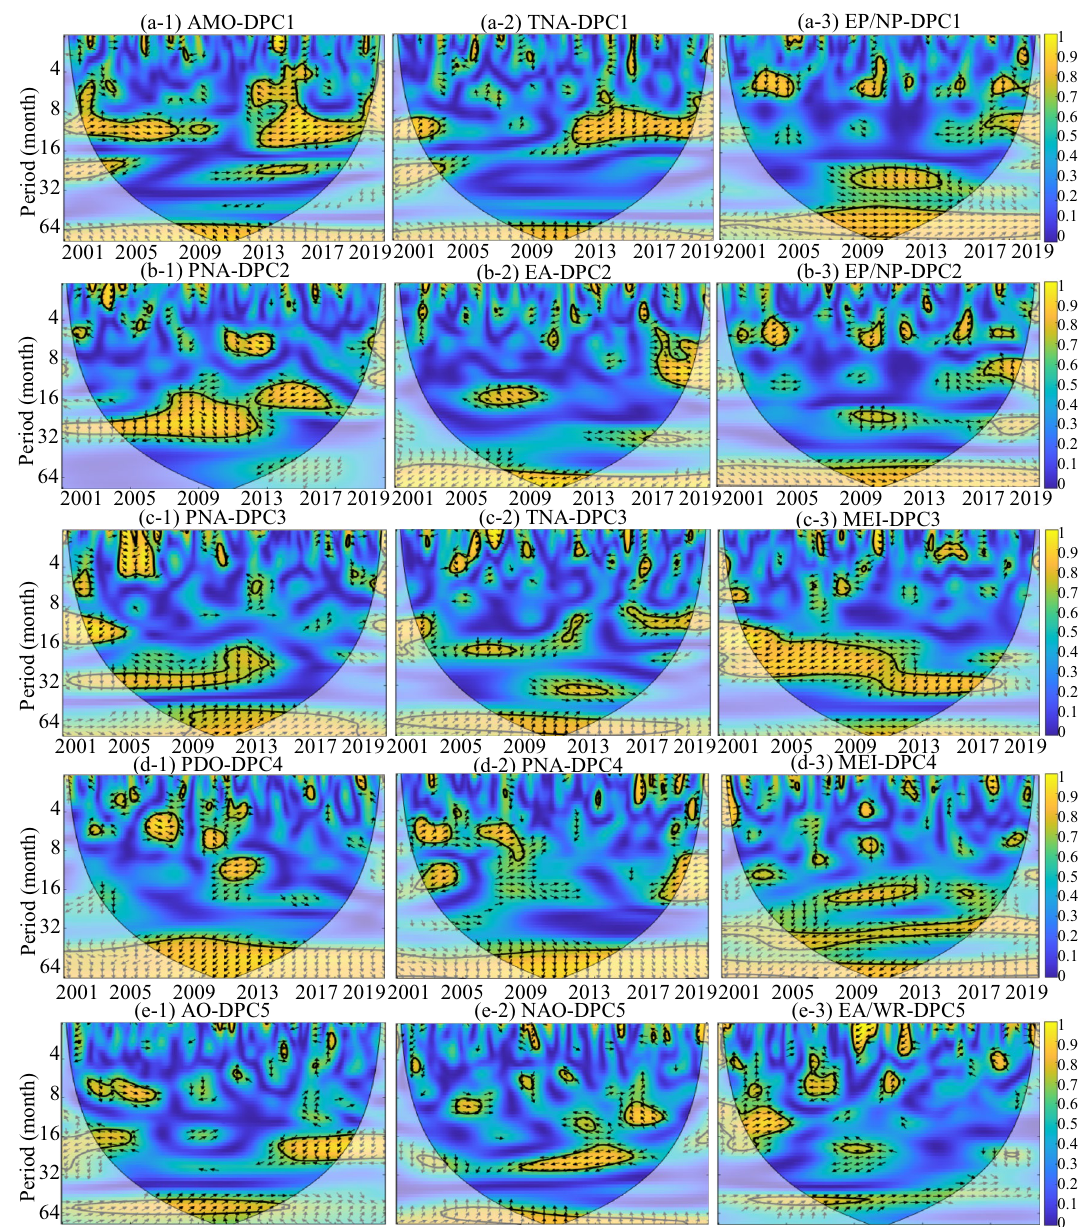
Figure 6. Squared wavelet coherence between the global climatic drivers and the temporal patterns of DPC1–5 (coherence coefficient between the global climatic drivers and DPCs). The black contour designates the 95% confidence level against red noise, and the COI, where edge effects might distort the picture, is shown as a lighter, paler shade. In addition, the phase lags are illustrated by black arrows. The y-axis represents the coherence period, and the color represents the level of the coherence coefficient. This figure was generated using MATLAB version R2020b (https:// jp. mathw orks. com/). The data used in the calculation comes from Fire CCI v5.1 dataset (https:// geogra. uah. es/ fire_ cci/ firec ci51. php) and NOAA (https:// psl. noaa. gov/ data/ clima teind ices/